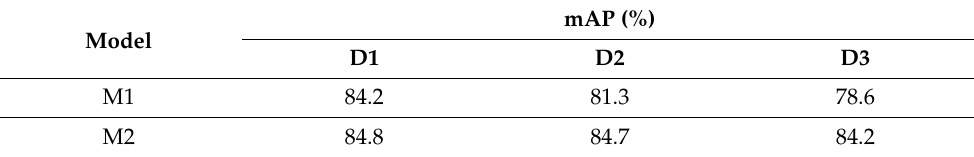
Table 4. Comparison between models with and without using data augmentation.